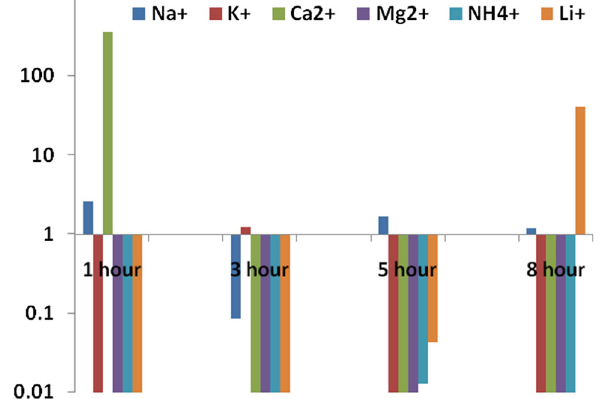
Fig. 10 Change in concentration of cations (in ppm) in aqueous leachates of Ledo coal (LC-60A) with leaching time at 65 (cid:3) C